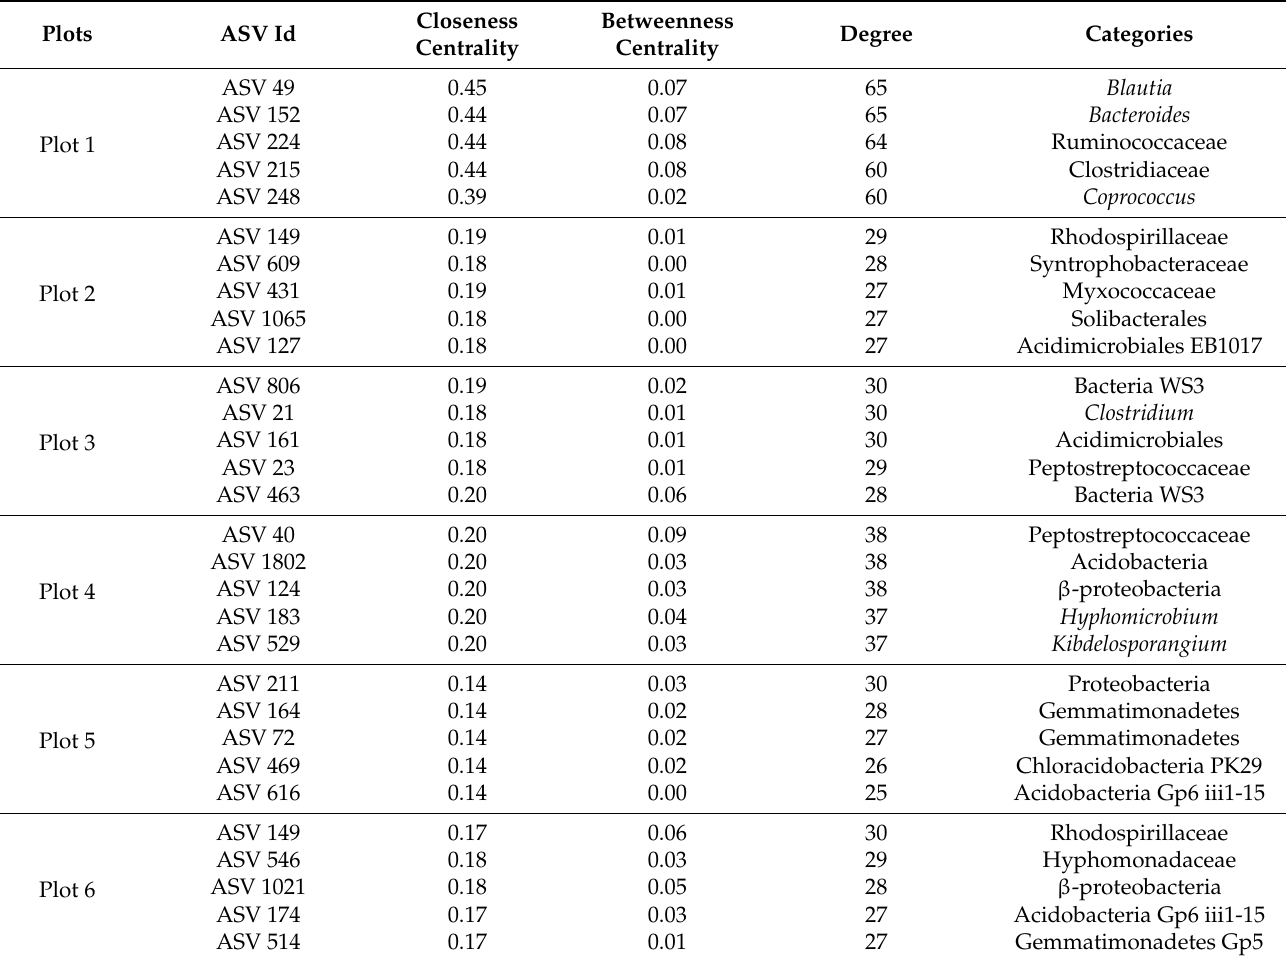
Table 5. Keystone taxa of soil bacteria in different